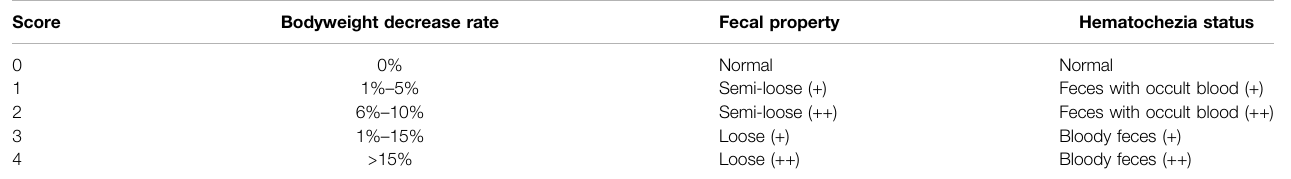
TABLE 2 | Clinical scoring system.